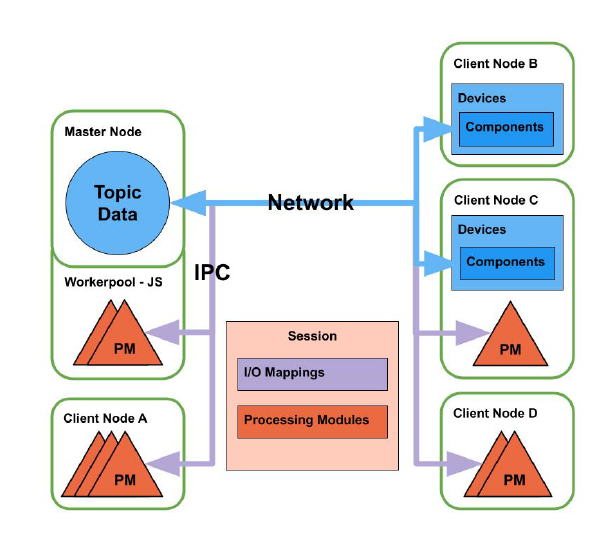
Figure 2. Node and data organization. Nodes can be connected via network or Inter-Process-Communication (IPC). Sessions provide runtime environments for Processing Modules, mapping between topics and a module’s input/output